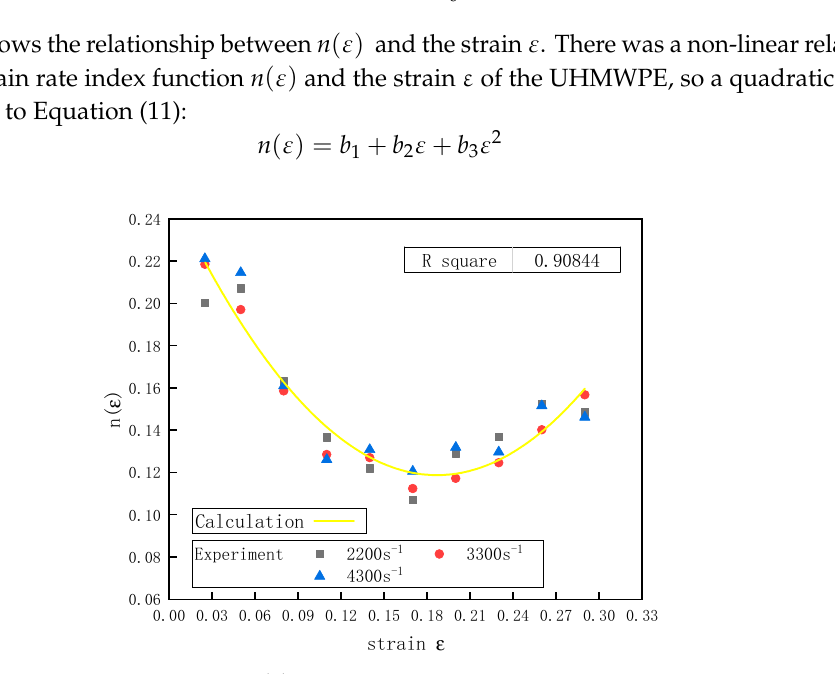
Figure 7. The relationship between 𝑀(𝜀, 𝜀(cid:4662)) and 𝜀 at a temperature of 20 °C and different strain rates.